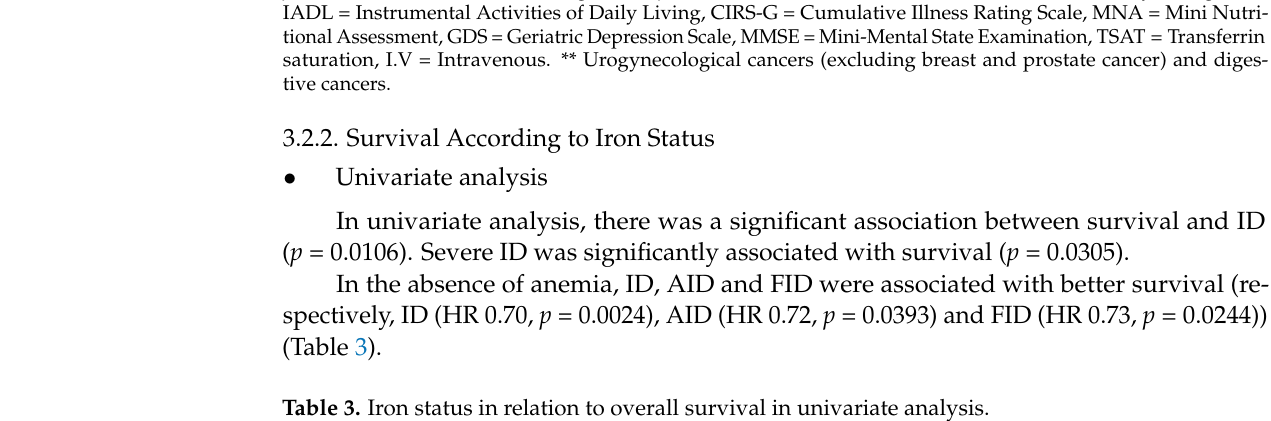
Table 3. Iron status in relation to overall survival in univariate